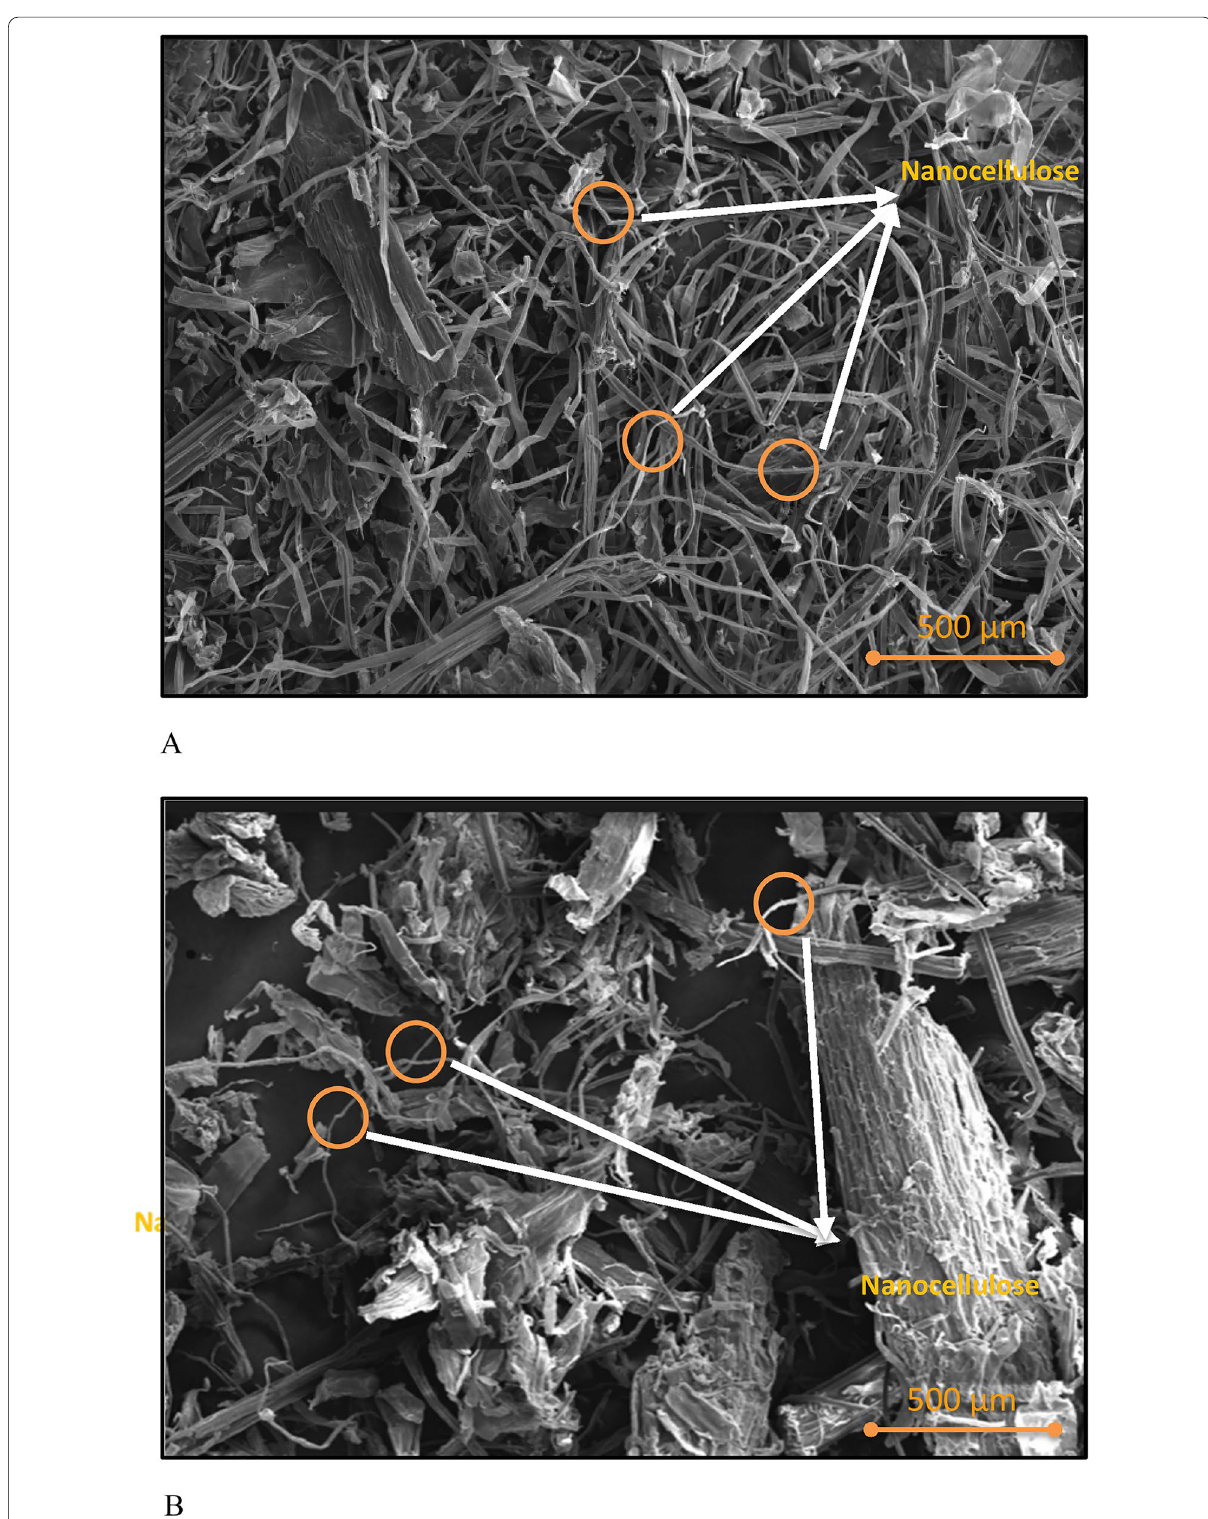
Fig. 8 A SEM images for the nanocellulose–laccase